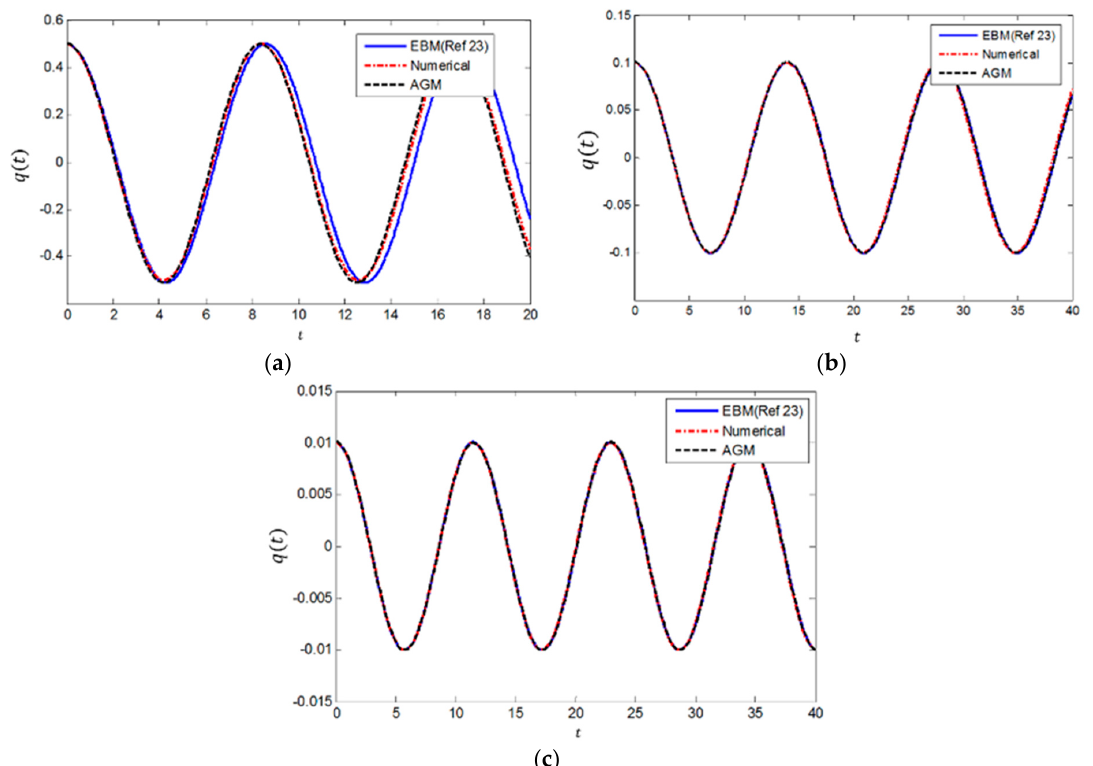
Figure 3. Comparison between obtained results of q(t) by AGM and numerical method for ( a ) mode1 ( λ = 0.5 , A = 0.5), ( b ) mode 2 ( λ = 0.2 , A = 0.1), and ( c ) mode 3 ( λ = 0.3 , A = 0.01).